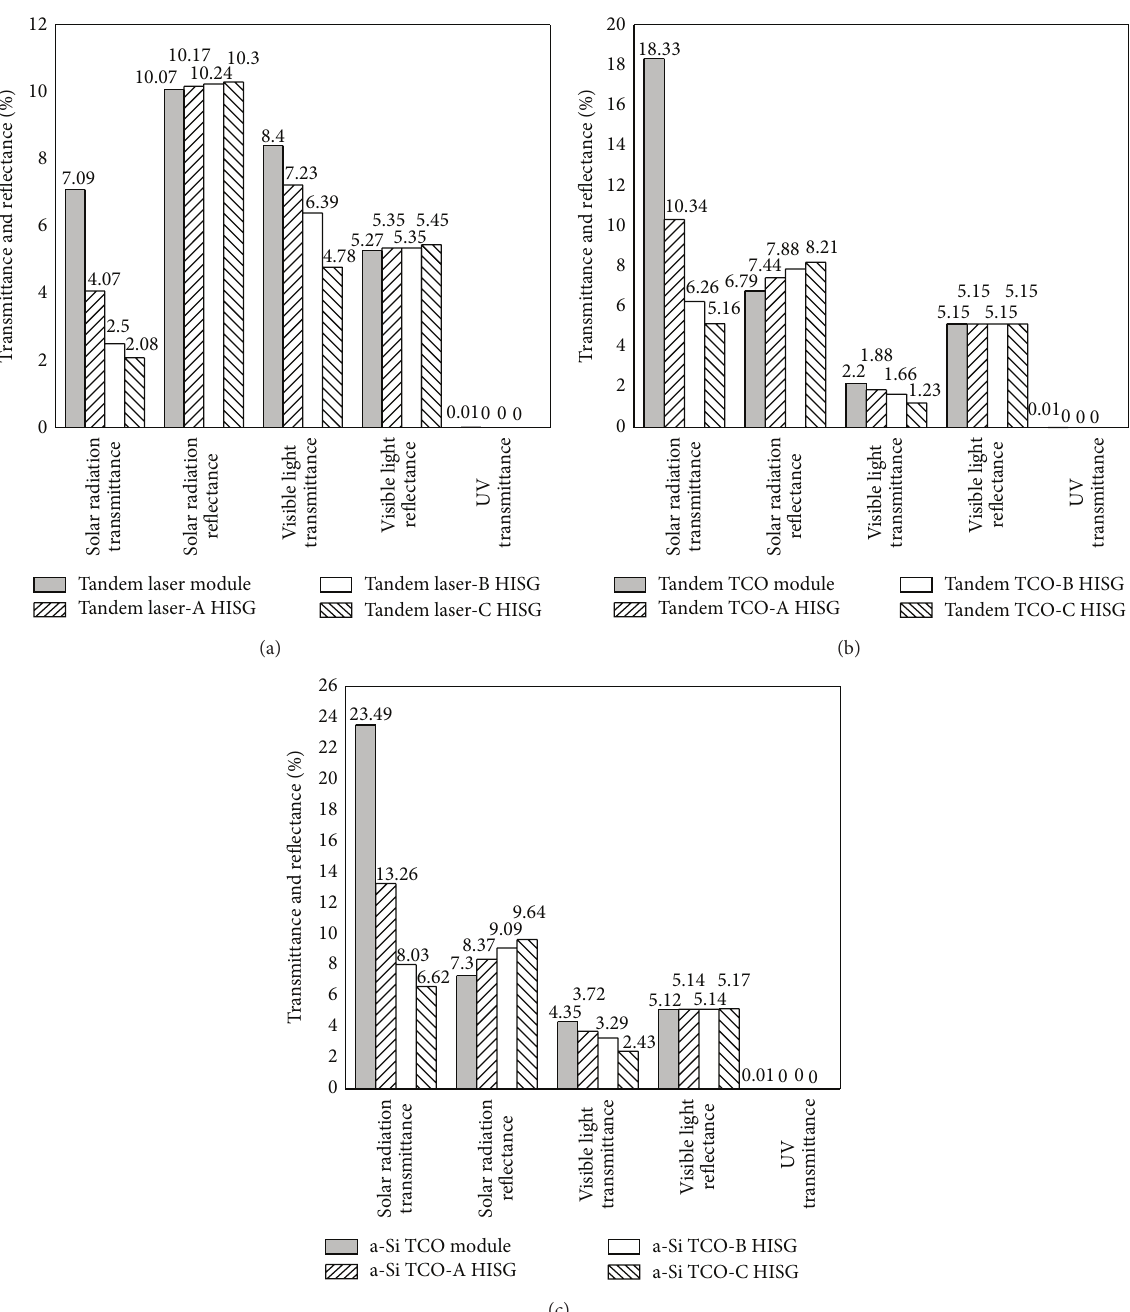
Figure 6: Optical properties of the HISGs: (a) tandem laser module, (b) tandem TCO module, and (c) a-Si TCO module.